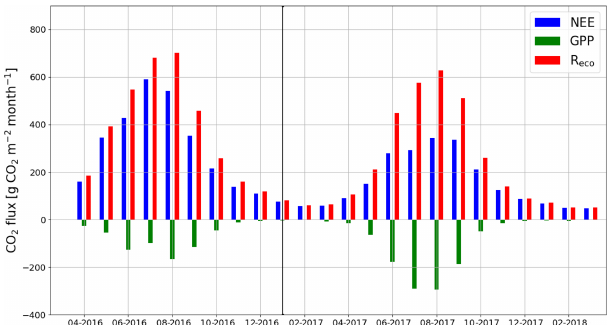
Figure 7. The monthly sums of net ecosystem exchange (NEE), gross primary production (GPP) and ecosystem respiration ( R eco ) based on EC data in April 2016–March